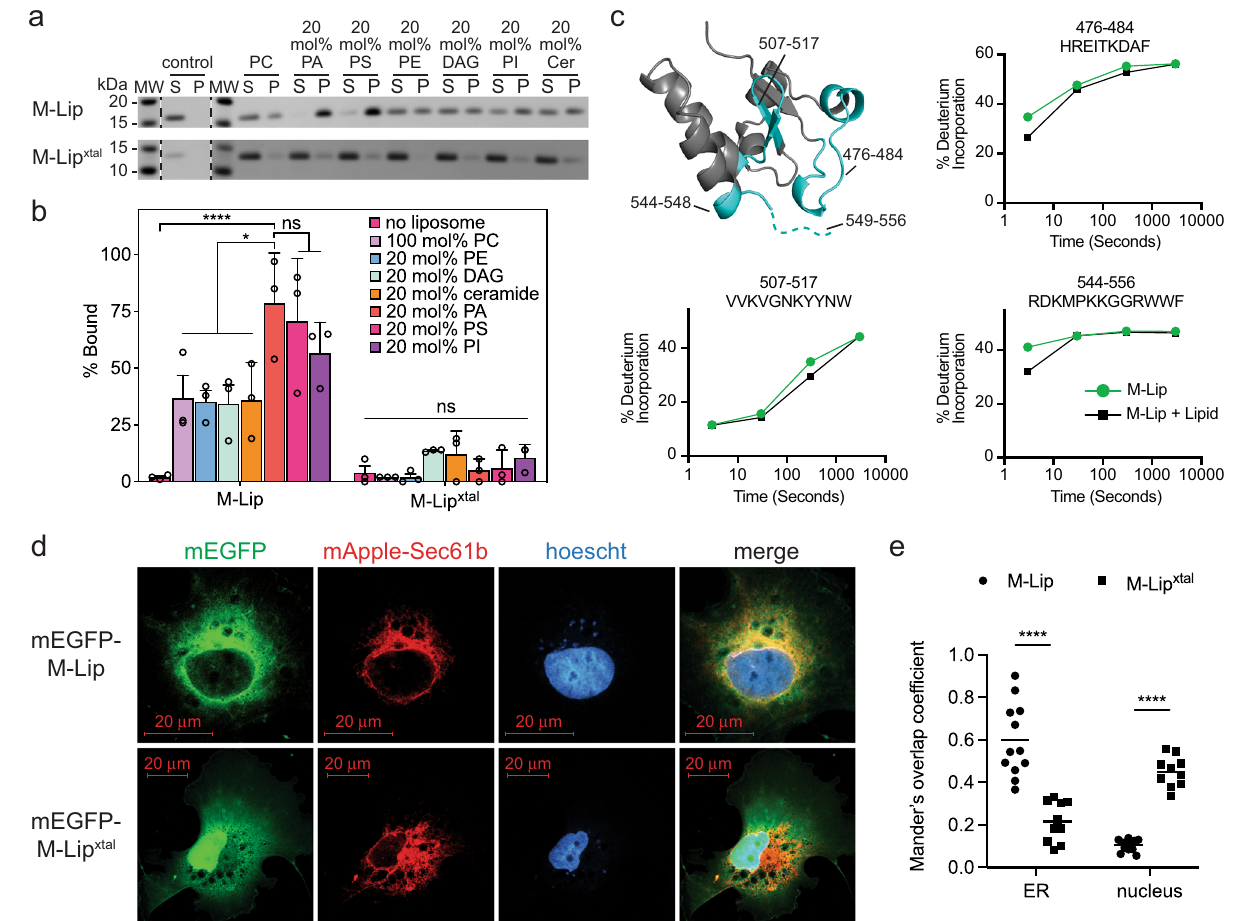
Fig. 4 The M-Lip domain binds membranes in vitro and in cells. a SDS-PAGE analysis of liposome sedimentation assays reveal the M-Lip domain binds membranes and preferentially associates with liposomes containing anionic lipids (PA, PS, and PI). The M-Lip xtal domain binds weakly to membranes. S supernatant, P pellet, MW molecular weight markers, PC phosphatidylcholine, PE phosphatidylethanolamine, PA phosphatidic acid, PS phosphatidylserine, DAG diacylglycerol, PI phosphatidylinositol, Cer ceramide. Representative images from n = 3 independent experiments. b Quanti fi cation of liposome association for the M-Lip and M-Lip xtal domains. Data are presented as mean values ± SDs. n = 3 independent experiments. Statistical analysis by 2-way ANOVA with Tukey ’ s multiple comparison. ns, p > 0.05; * p < 0.05; **** p < 0.0001. c Regions that showed signi fi cant decreases in exchange (de fi ned as >4%, >0.4 Da, and a two-tailed student t -test p < 0.01) in the presence of liposomes are colored in blue according to the legend and displayed on a single subunit of the lipin 1 M-Lip xtal domain. % deuterium incorporation of selected peptides at various time points (3, 30, 300, and 3000 s) in the absence and presence of liposomes. Data are presented as mean values ± SDs. n = 3 independent experiments. Most SDs are smaller than the size of the point. d Confocal microscopy images of Cos-7 cells transiently transfected with monomeric enhanced GFP (mEGFP) fusions of either the M-Lip or M-Lip xtal domains (green) and the ER marker mApple-Sec61b (red). Hoechst stain (blue), nucleus. Scale bar: 20 μ m. n = 1 with independent images ( n = 3) shown in Supplementary Fig. 10. e Mander ’ s overlap coef fi cient calculated using JacoP plugin in ImageJ analyzed by 2-way ANOVA